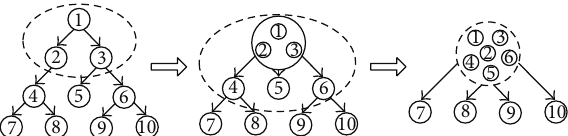
Figure 1: Consensus process of multiagent system under directed spanning